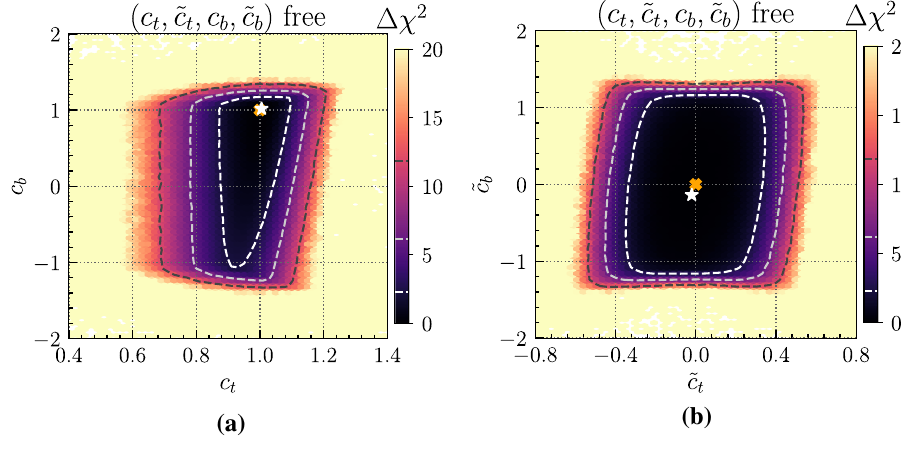
Fig. 4 2-flavor model( t + b ): fit results in the a ( c t , ) ‘ and b ( ˜ c t , ˜ c b ) parameter planes. In each case, the CP -even and CP -odd parts of the couplings shown in the plot are free-floating while all the other parameters are set to their SM values. The legend corresponds to the one in Fig.